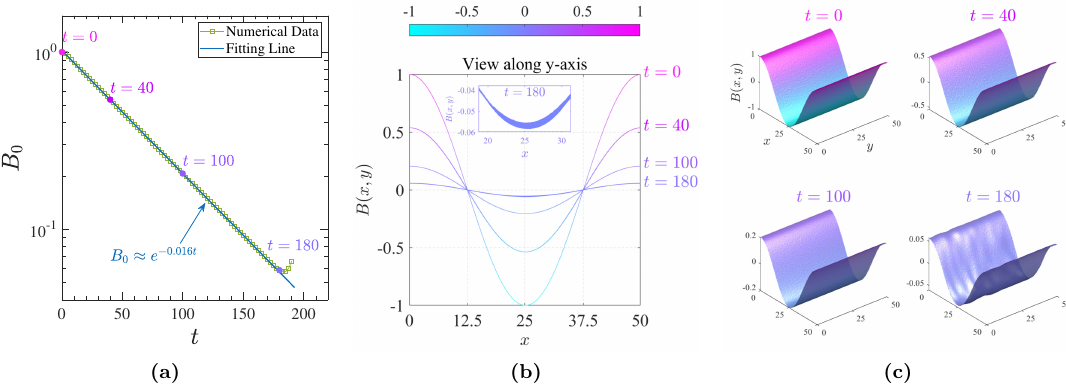
Figure 6. The exponential decay of magnetic field in the early stage with quench rate τ Q = 1000 and initial amplitude of magnetic field B 0 ( t = 0) = 1 . (a) Logarithmic plot of the time evolution of the amplitude of magnetic field. The linear dependence indicates an exponential decay of amplitude as B 0 ( t ) = B 0 ( t = 0) e − γt . The four instants ( t = 0 , t = 40 , t = 100 , t = 180) correspond to the four snapshots in the subsequent panels (b) and (c). Time t = 180 is the ‘trapping’ time that the amplitude deviates away from the exponential decay; (b) Configurations of the magnetic field at the four instants from the view parallel to y -axis. At the instants ( t = 0 , t = 40 , t = 100) the magnetic fields still maintain in a perfect plane-wave form with wave number k = 2 π/l where l = 50 . However, at the instant t = 180 the shape of the magnetic field starts to deviate from the plane-wave from, which can be seen from the inset picture that near the bottom of the curve ( x = l/ 2) it becomes thicker. This thickness comes from the ripples that the magnetic field will start to form lumps and finally to shape the vortices; (c) 3D visualizations of the magnetic field at the four instants. At ( t = 0 , t = 40 , t = 100) the magnetic fields are perfectly in the plane-wave shapes along x -axis and very smooth along the y -axis. However, at t = 180 ripples turn out in the magnetic field since the order parameter gets bigger and ruins the exponential decay of the magnetic field. These ripples will finally form lumps and then vortices of the magnetic field,